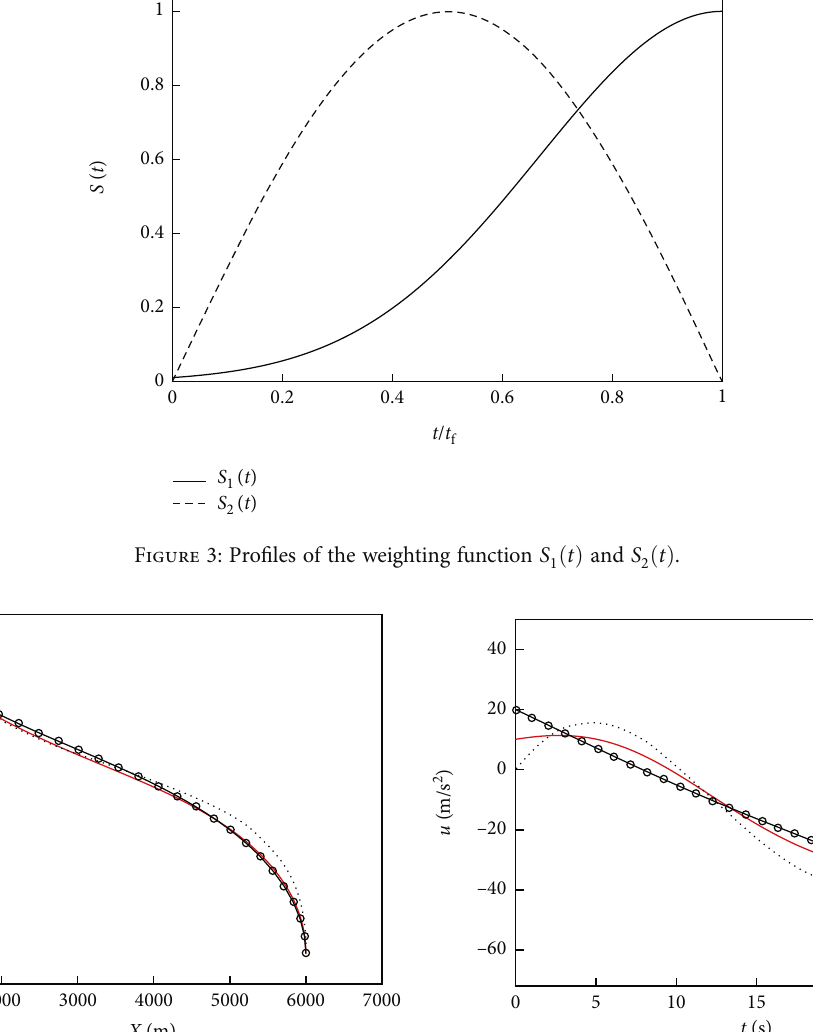
Figure 4: The comparison results of di ff erent weighting functions for γ